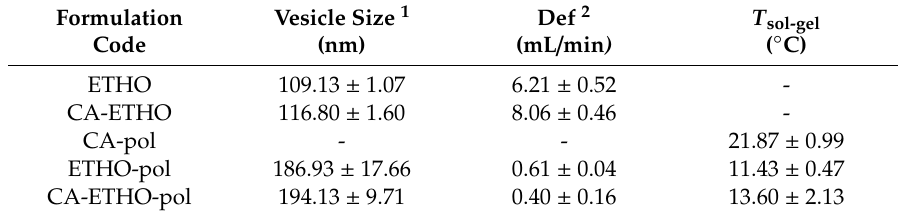
Table 3. Deformability parameters and transition temperatures of the indicated